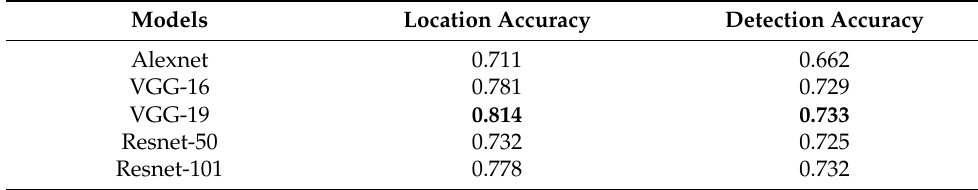
Table 2. Accuracies of different baseline network models.